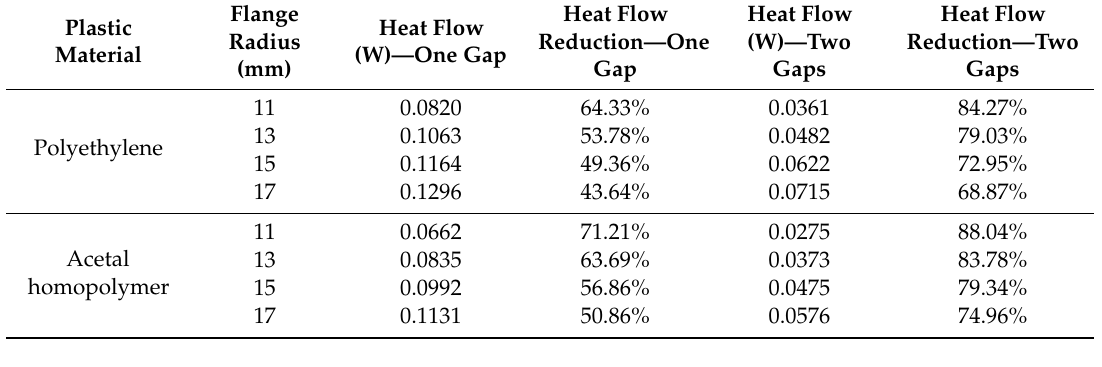
Table 1. Calculated heat flow and heat flow reduction of polyethylene and acetal homopolymer compared to case of coaxial line with no gaps.